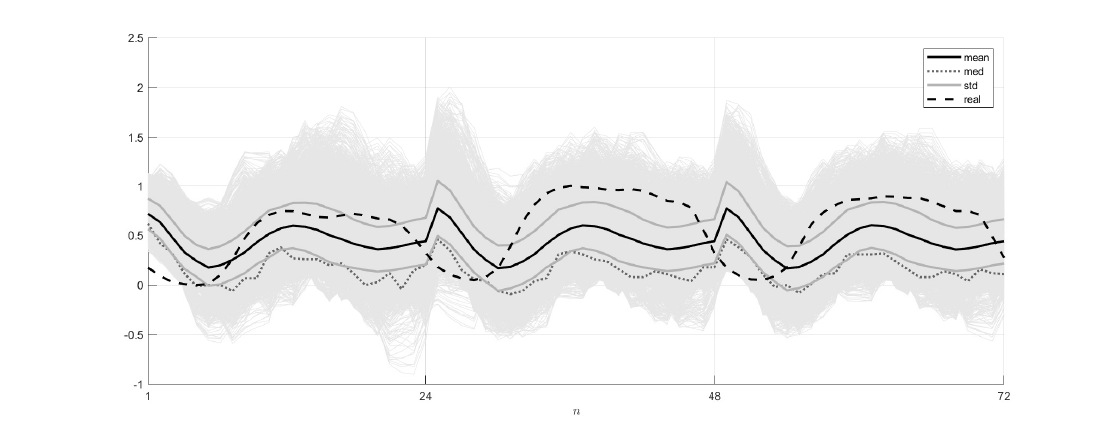
Figure 6. 24-h, 48-h and 72-h forecasts using LT ξ